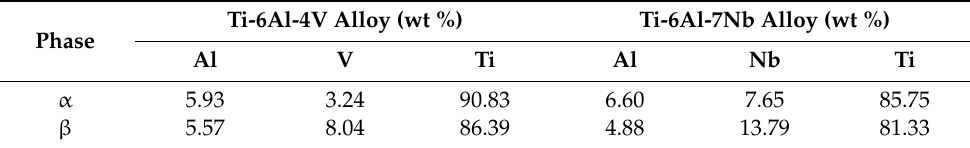
Table 4. Chemical composition (wt %) of different phases in Ti-6Al-4V and Ti-6Al-7Nb alloys.